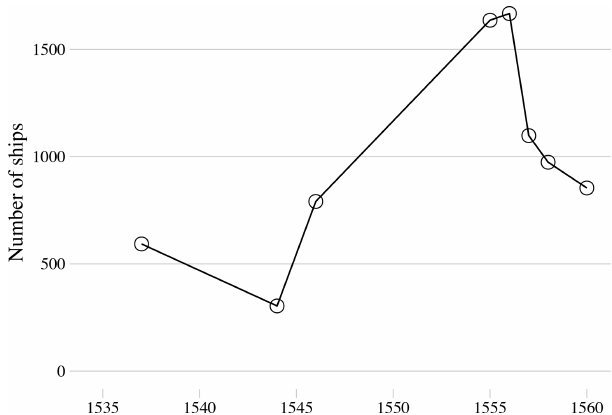
Figure 17. Number of ships registered in Włocławek water cham- ber. Source: Kutrzeba and Duda